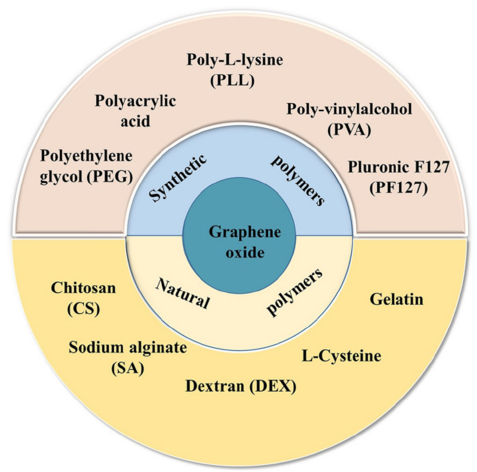
Figure 2. Materials used for the surface modification of GO. Reproduced from Ref. [59] with per- mission from Springer Nature.